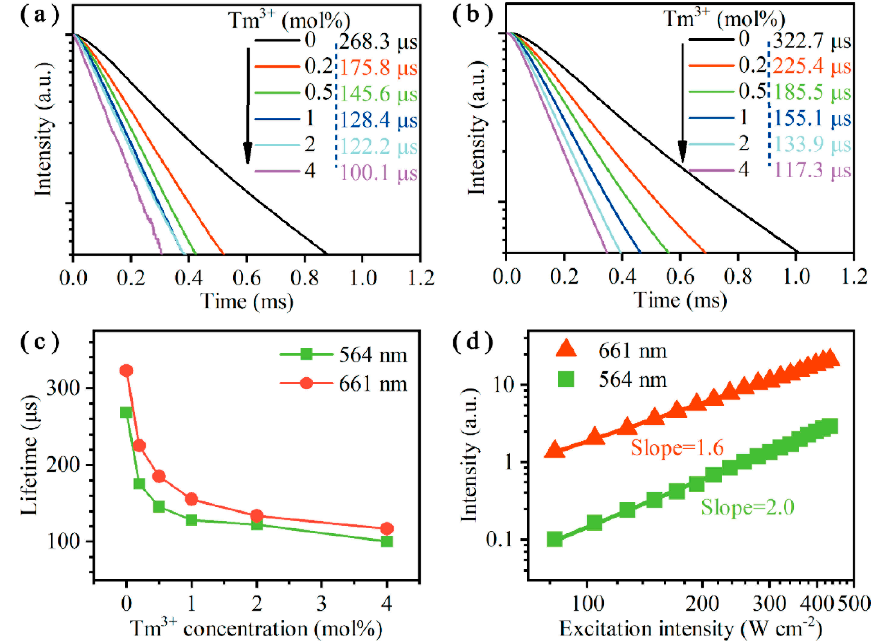
Figure 6. Time–decay curves of the ( a ) 564 nm and ( b ) 661 nm UCL for the UCNPs doped with different concentration of Tm 3+ ions (the vertical axis is in log scale). ( c ) The lifetime trends of 4 S 3/2 and di ff erent concentration of Tm 3 + ions (the vertical axis is in log scale). ( c ) The lifetime trends of 4 S 3 / 2 and 4 F 3 + doping concentrations. ( d ) UCL intensities of Y 3 + / Tm 3 + 4 F 9/2 states as a function of the Tm 3+ doping concentrations. ( d ) UCL intensities of Y 2 O 3 :Er 3+ /Tm 3+ (8/1 9 / 2 states as a function of the Tm 2 O 3 :Er (8 / 1 mol%) UCNPs as a function of excitation intensity. All excited by a 980 nm mol%) UCNPs as a function of excitation intensity. All excited by a 980 nm laser.